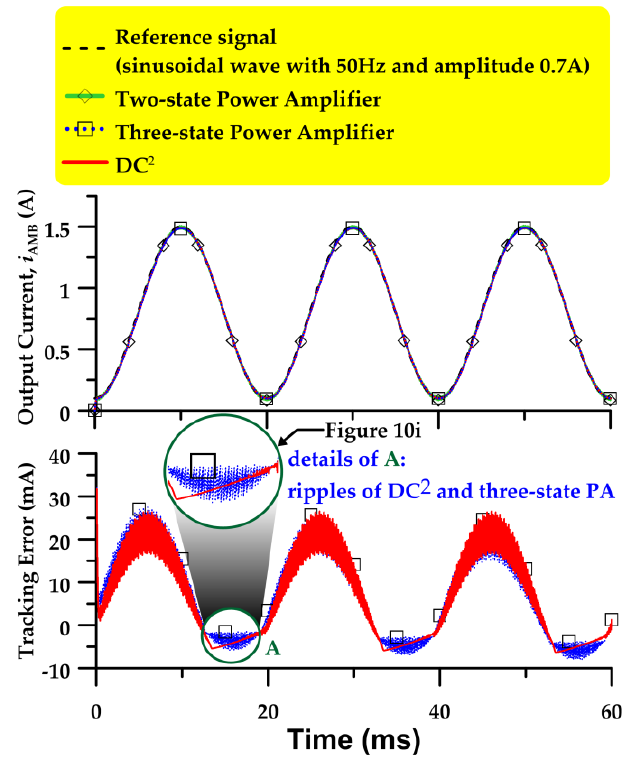
Figure 10. Output currents and tracking errors by two-state power amplifier, three-state power amplifier and DC 2 (dual cooperative drive circuit). (Reference signal: sinusoidal wave with 50 Hz and amplitude 0.7 A).